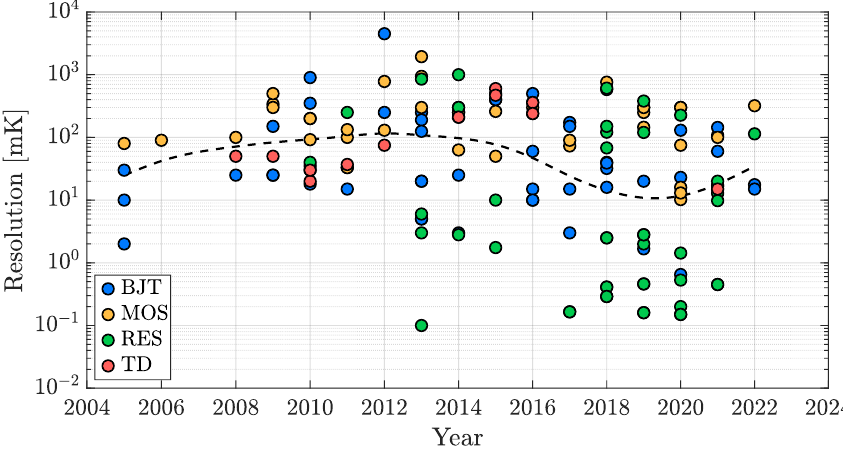
Figure 10. TDC resolution time evolution in the last two decades.